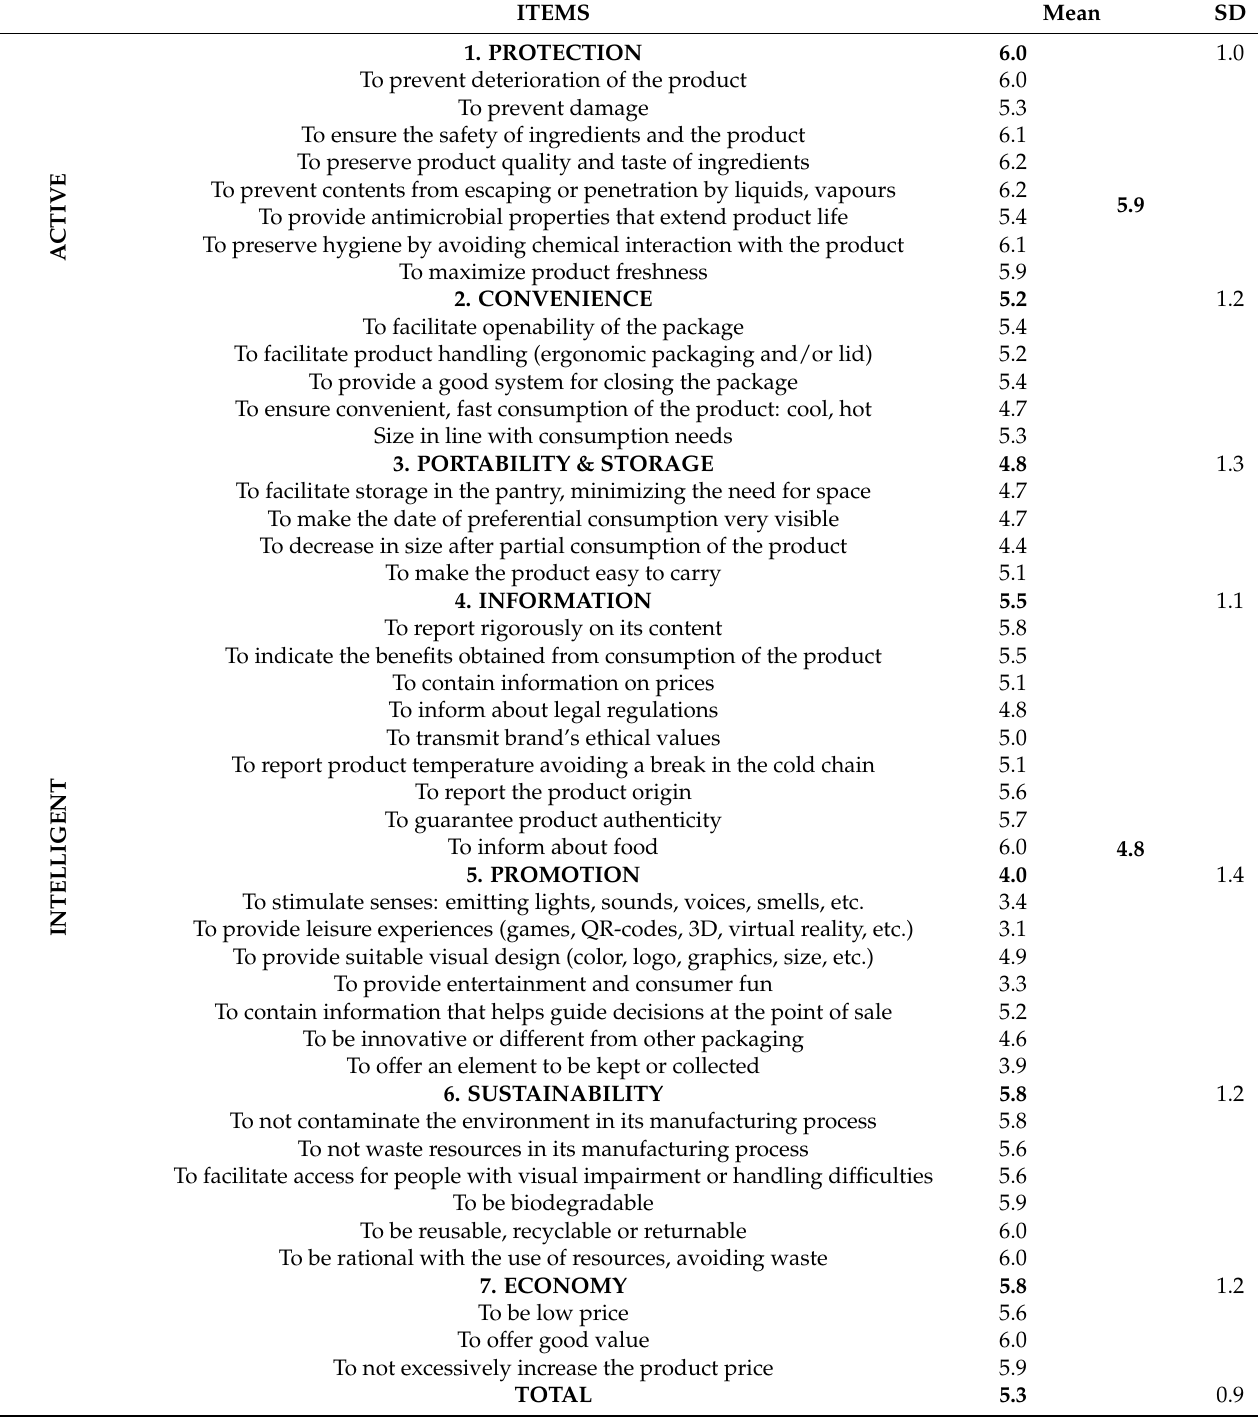
Table 2. Value perception of packaging